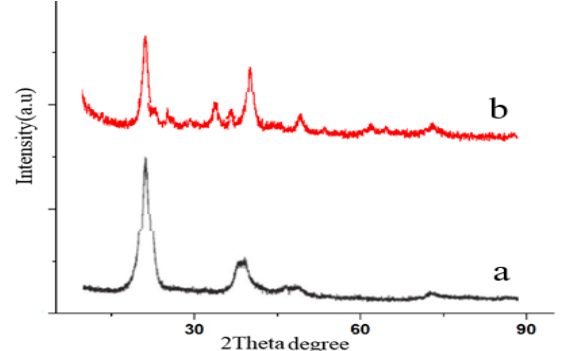
Fig. 3. XRD of (A) raw MWCNT and (B) chitosan- modified MWCNT nanocomposites